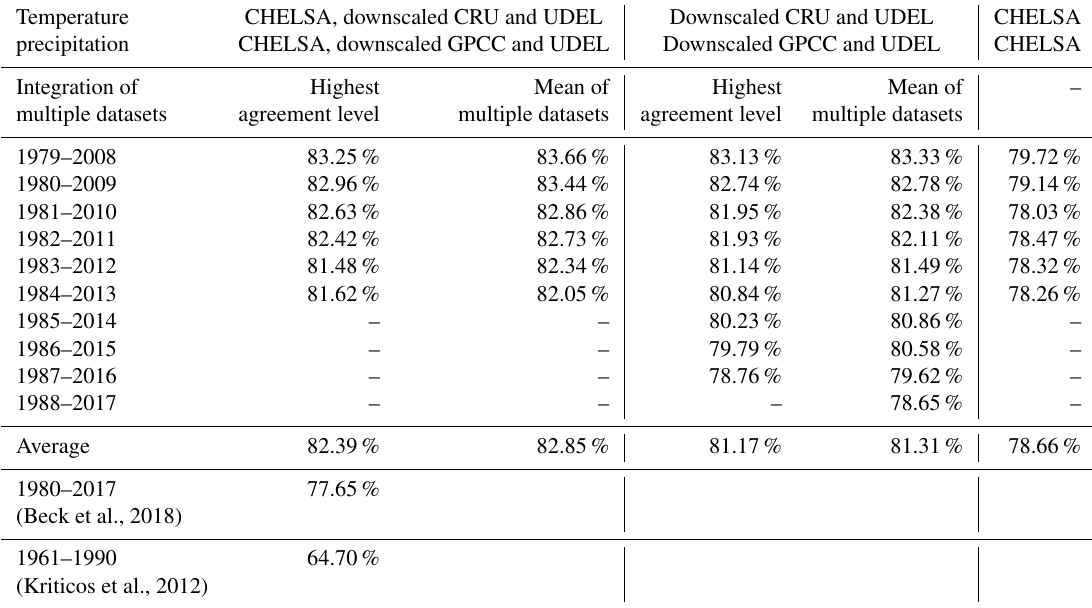
Table 4. Accuracy of the 1km Köppen–Geiger climate map series derived from different combinations of temperature and precipitation dataset input and by different means of integration of multiple datasets. The values represent overall accuracy based on the technical validation using ground observation as